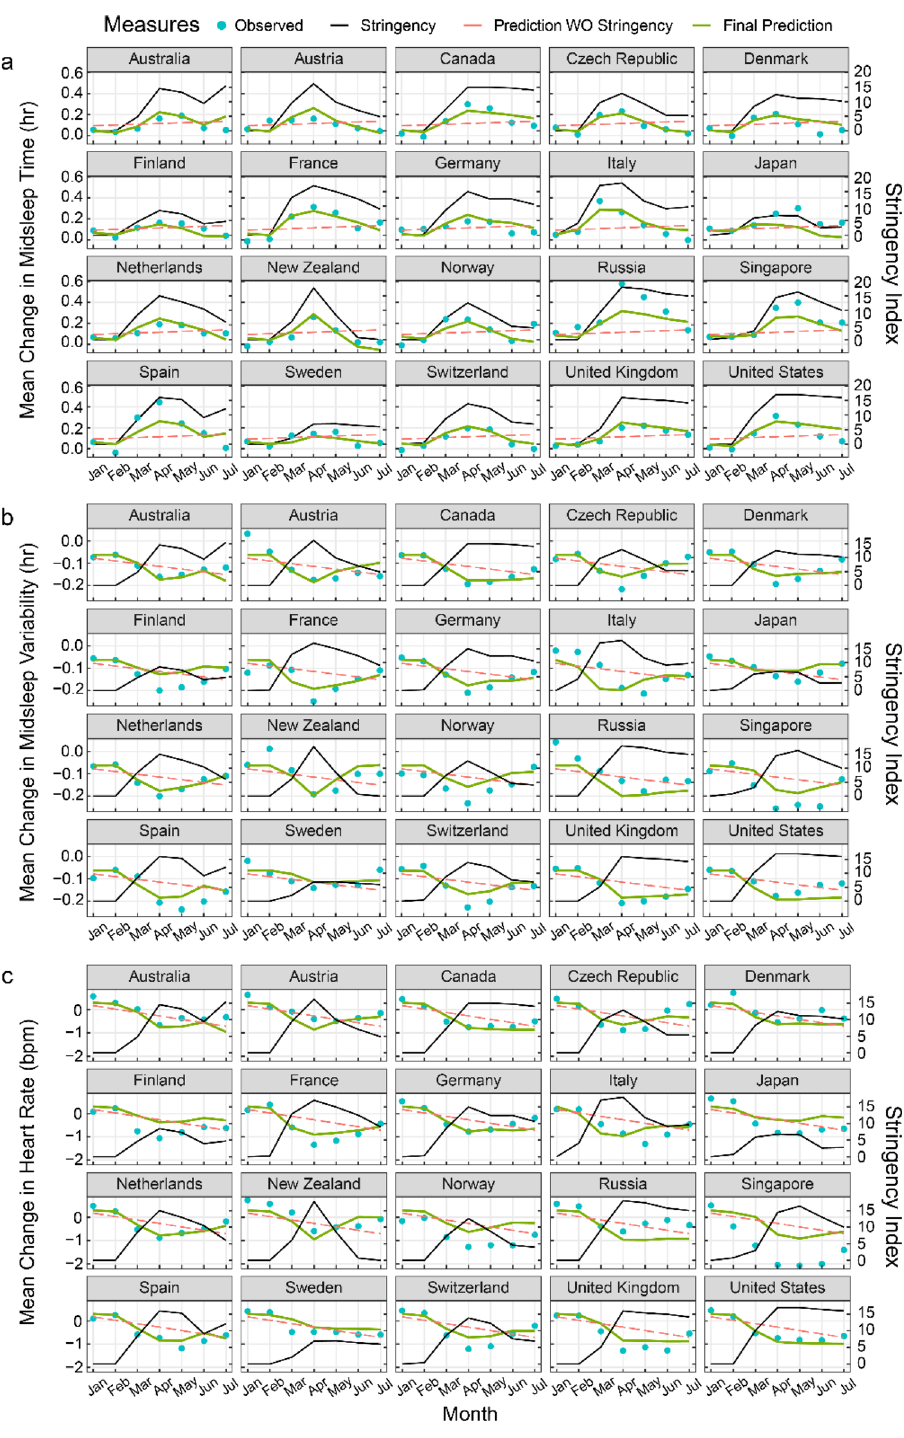
Figure 3. Prediction of changes in sleep patterns and resting heart rate by lockdown stringency. Plots for fitted models (green curves) across 20 countries estimating changes in ( a ) midsleep time, ( b ) midsleep variability and ( c ) resting heart rate using lockdown stringency as a predictor. Observed mean differences between 2020 and 2019 (blue dots), lockdown stringency (black line) and predictions without (WO) lockdown stringency in the model (red dashed line) are also shown for